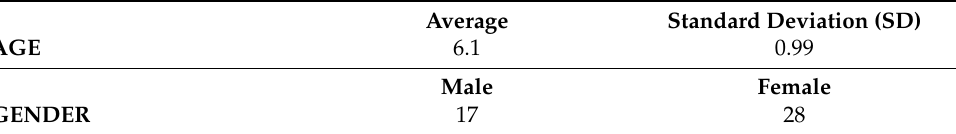
Table 1. Distribution of gender and age.